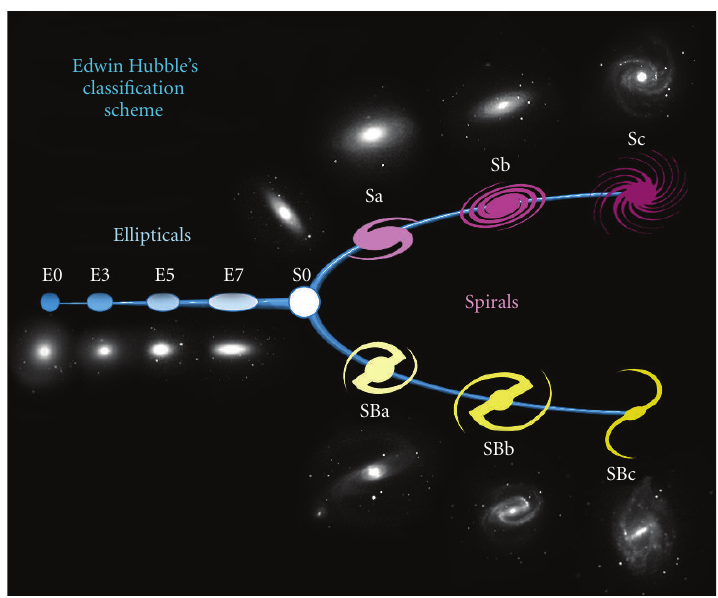
Figure 1: The Hubble tuning fork diagram. A schematic view of the Hubble galaxy classification. Credit: NASA and